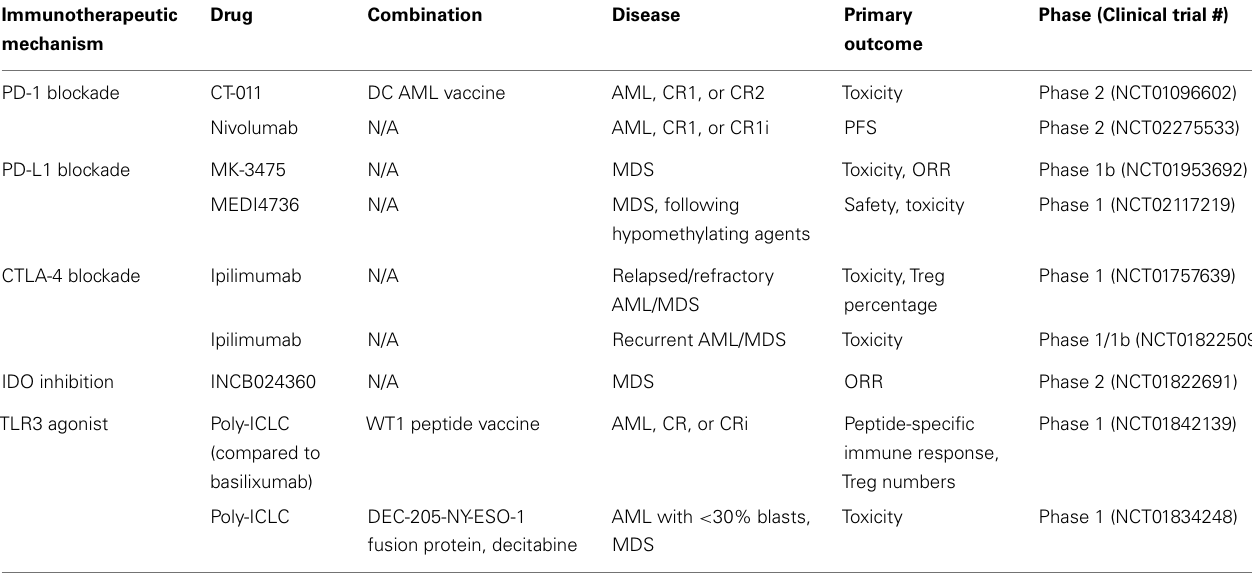
Table 1 | Select ongoing trials inAML/MDS